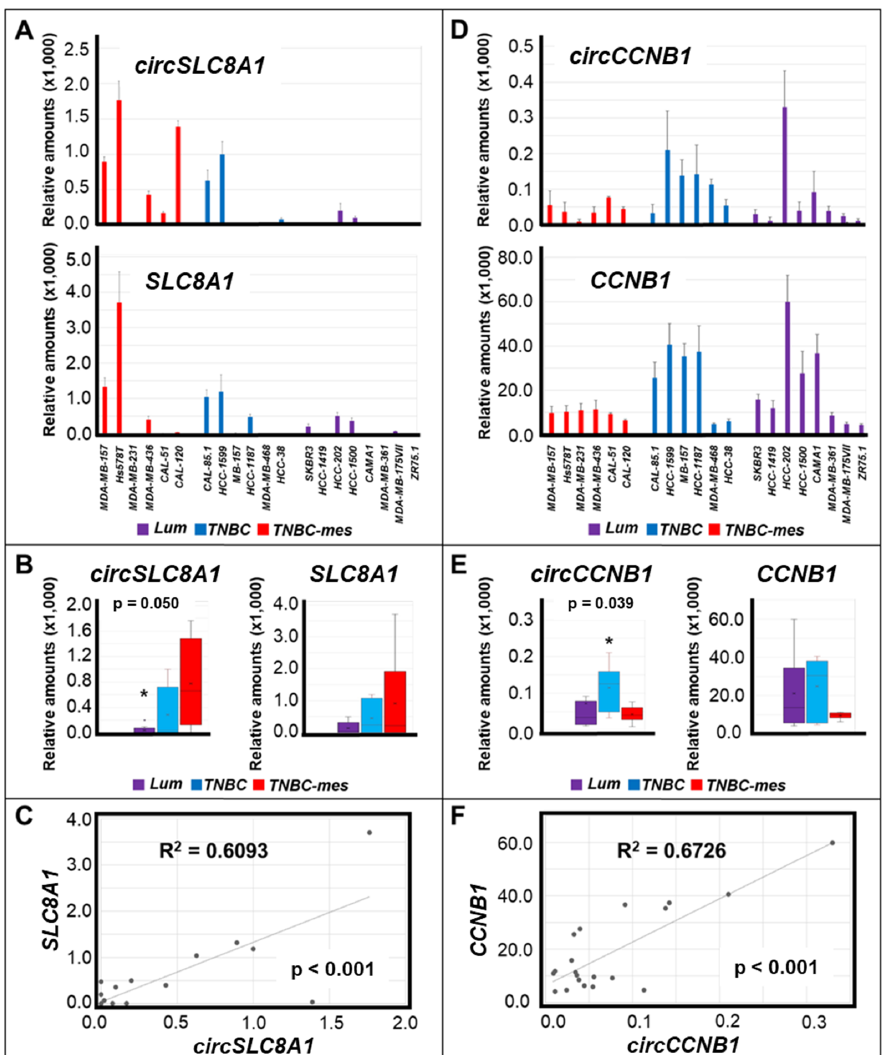
Figure 1. Expression of circSLC8A1 and circCCNB1 RNAs as well as the corresponding linear SLC8A1 and CCNB1 mRNAs in breast cancer cell lines. ( A ) Total RNA was extracted from the indicated cell lines and the levels of circSLC8A1 RNA (upper graph) and SLC8A1 mRNA (lower graph) were measured by PCR in the indicated cell lines. Each value is the mean ± SD of 3 independent cultures. ( B ) The panel illustrates the box plots generated from the median expression levels of circSLC8A1 RNA and SLC8A1 mRNA determined in Lum, TNBC, and TNBC ‐ mes cell lines and it summarizes the results shown in ( A ). * Significantly lower in the Lum relative to the TNBC ‐ mes group, as indicated ( p = 0.050; Student’s T ‐ test). ( C ) The panel illustrates the correlations between the mean expression of circSLC8A1 RNA and SLC8A1 mRNA in each cell line. The calculated R 2 correlation value (Pearson method) and the correlation p ‐ value are indicated. ( D ) Total RNA was extracted from the indicated cell lines and the levels of circCCNB1 RNA (upper graph) and CCNB1 mRNA (lower graph) were measured by PCR in the indicated cell lines. Each value is the mean ± SD of 3 independent cultures. ( E ) The panel illustrates the box plots generated from the median expression levels of circCCNB1 RNA and CCNB1 mRNA determined in Lum, TNBC, and TNBC ‐ mes cell lines and it summarizes the results shown in ( D ). * Significantly higher in the TNBC relative to the TNBC ‐ mes group, as indicated ( p = 0.039; Student’s T ‐ test). ( F ) The panel illustrates the correlations between the mean expression of circCCNB1 RNA and CCNB1 mRNA in each cell line. The calculated R 2 correlation value (Pearson method) and the correlation p ‐ value are indicated.